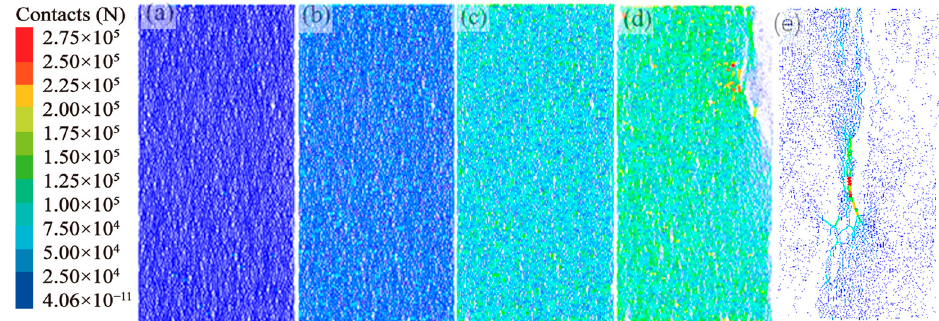
Figure 7. Force chain diagram of a numerical experiment at different stress levels ( a ) 0.1 σ c ; ( b ) 0.4 σ c ; ( c ) 0.8 σ c ; ( d ) σ c ; ( e ) 0.1 σ c .